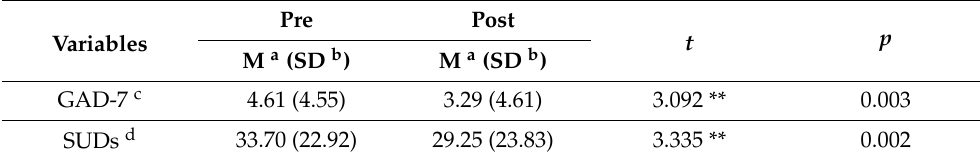
Table 2. Comparison of measurements within the intervention group.